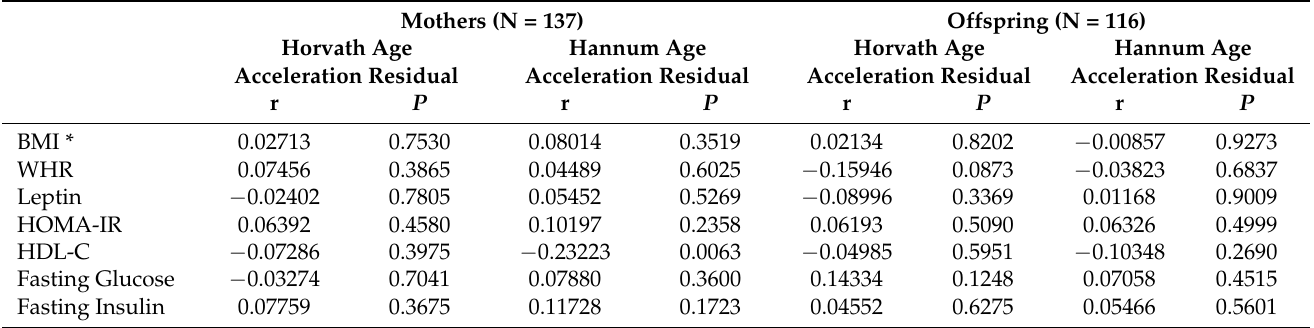
Table 2. Correlation of epigenetic age acceleration residuals and metabolic biomarkers in mothers and offspring. Mothers (N = 137)